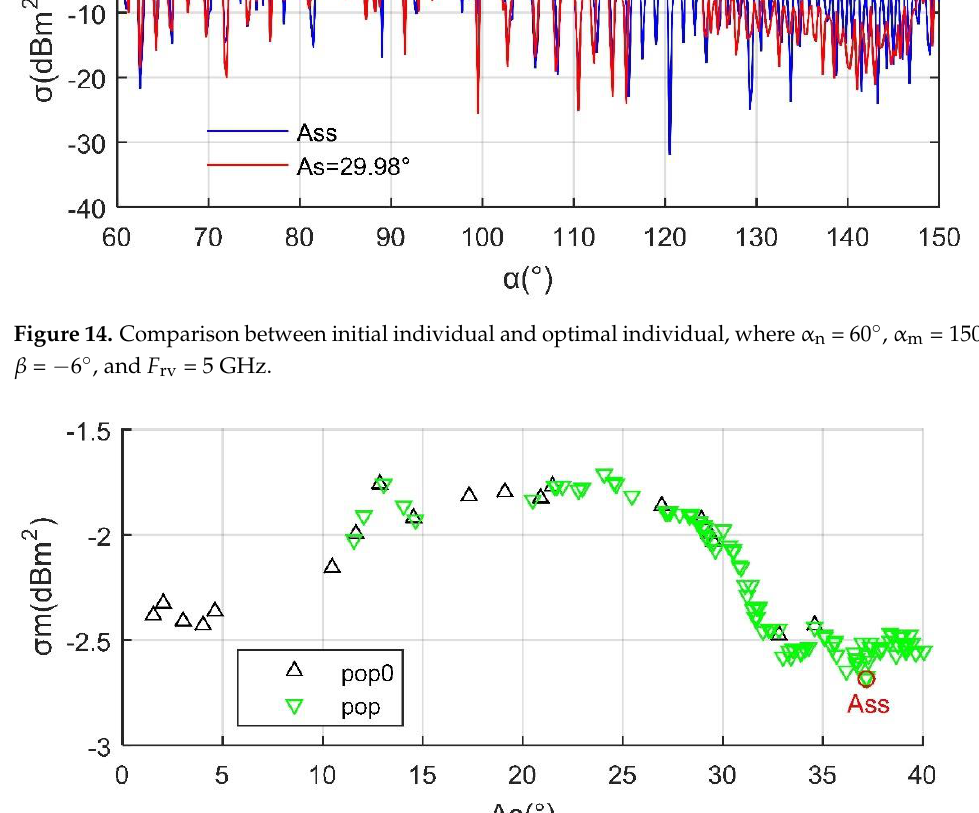
Figure 15. Auto sweep angle for the aircraft, where α n = 30° , α m = 120°, β = − 6°, and F rv = 5 GHz.